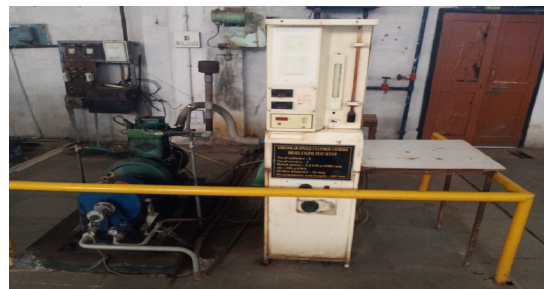
Fig. 1: Photograph of a 4-stroke CI Test-Setup